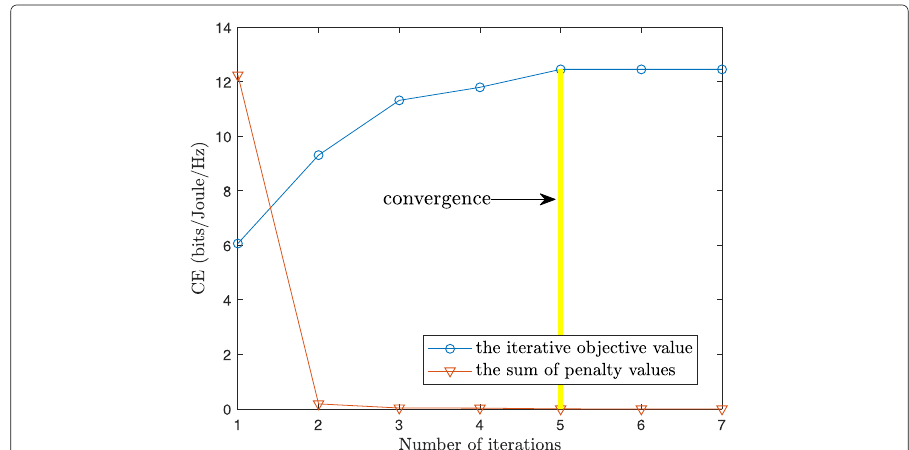
Fig. 3 Convergence of Algorithm 1 with respect to the iterative objective value and the sum of penalty values under the partial offloading mode